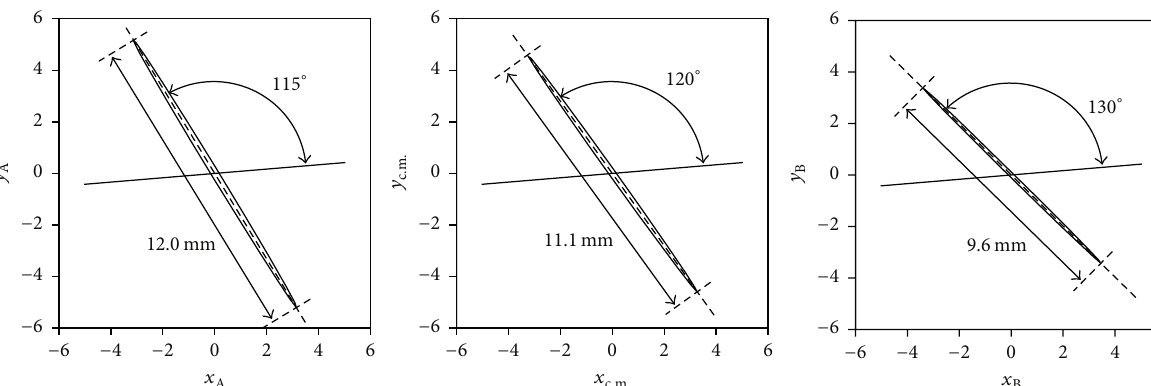
Figure 6: Movement in mm front supporting position (A), center of mass (c.m.), and rear supporting position (B) for nominal operating conditions, empty screen.